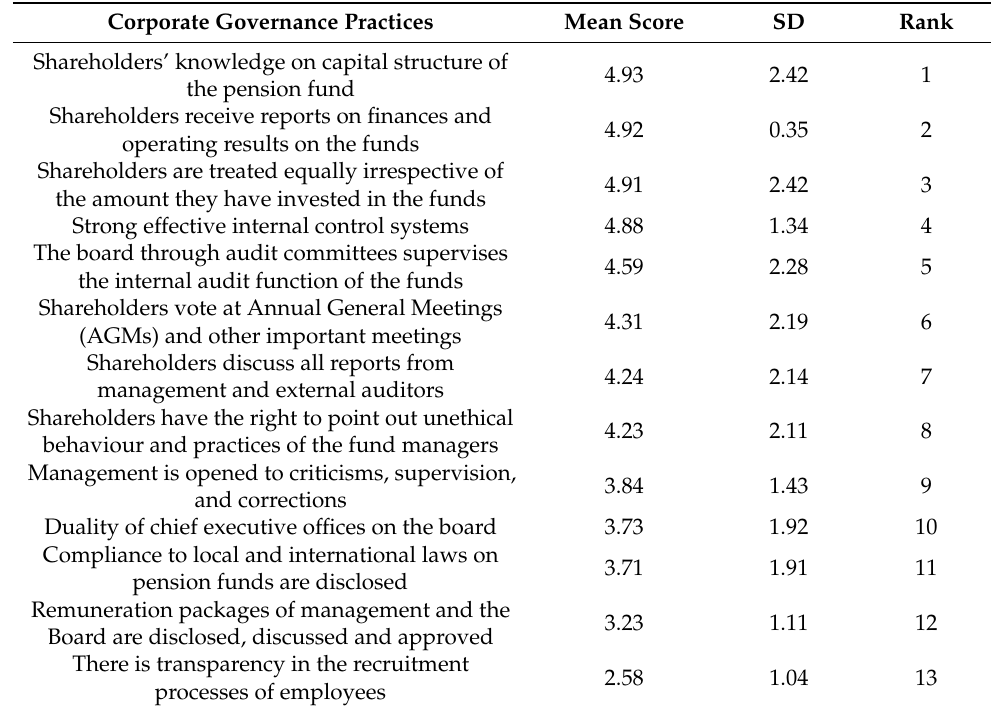
Table 2. Corporate governance practices of pension